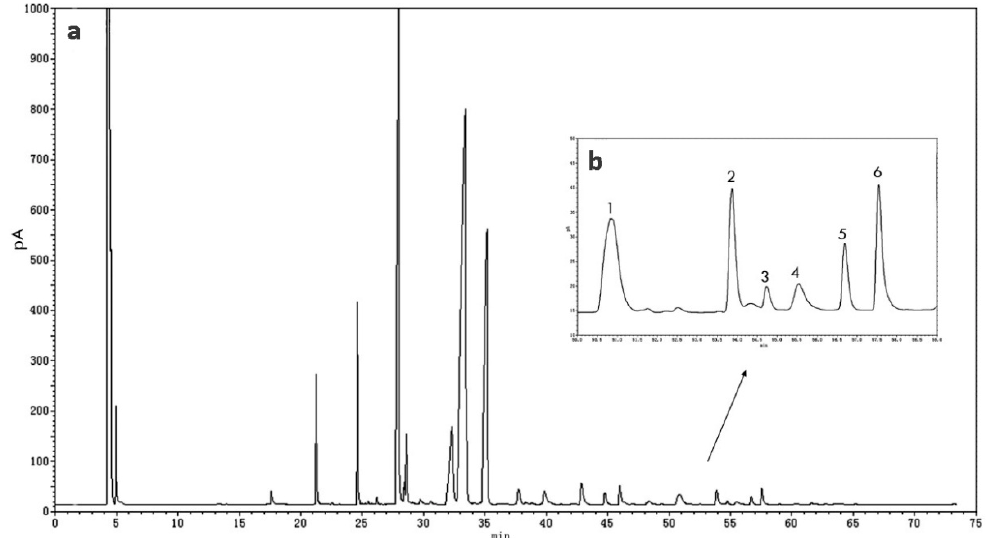
Figure 1. Gas chromatography (GC) of total fatty acids ( a ) and very-long-chain fatty acids ( b ) in one colostrum human milk. 1, tricosanoicacid (23:0); 2, docosatetraenoic acid (22:4 n-7); 3, docosapentaenoic acid (22:5 n-6); 4, nervonic acid (24:1 n-9, NA); 5, docosapentaenoic acid (22:5 n-3); 6, docosahexaenoic acid (22:6 n-3).